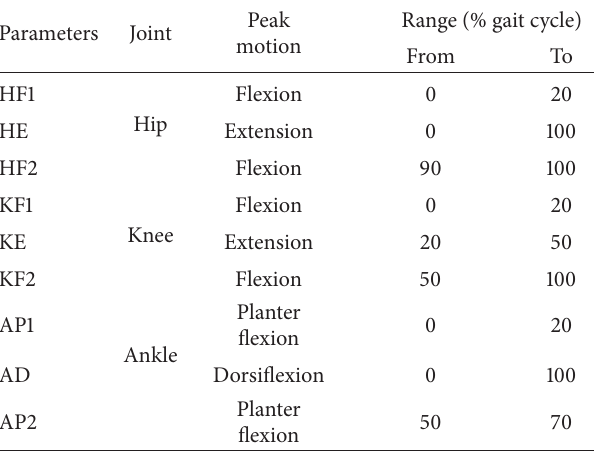
Table 2: Determined peak position during gait cycle at three